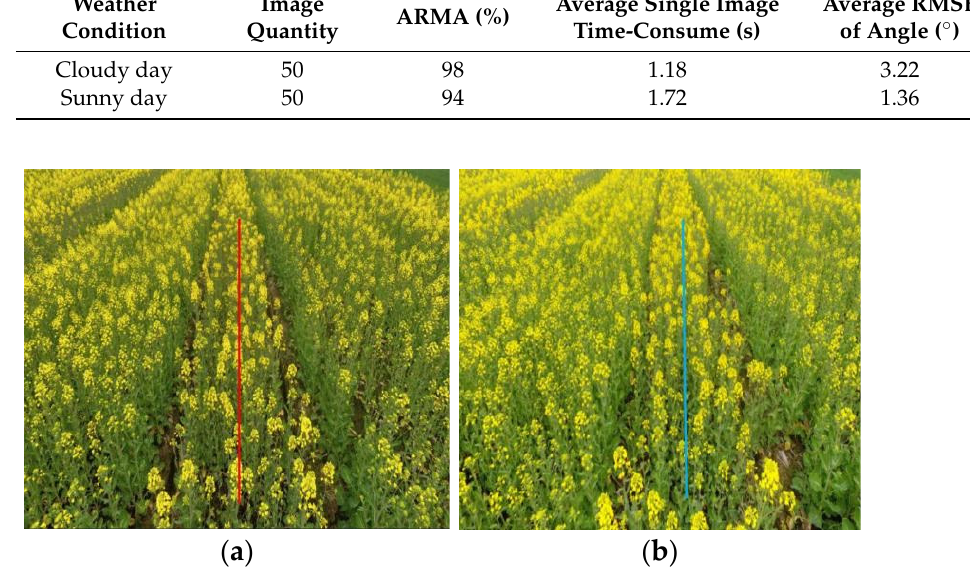
Figure 8. ( a ) Cloudy day ( b ) Sunny day. Extraction and fitting results of male OSR plant row center line under different lighting conditions. Note: The red and blue solid lines are the male OSR row center lines extracted and fitted by the method in this paper.